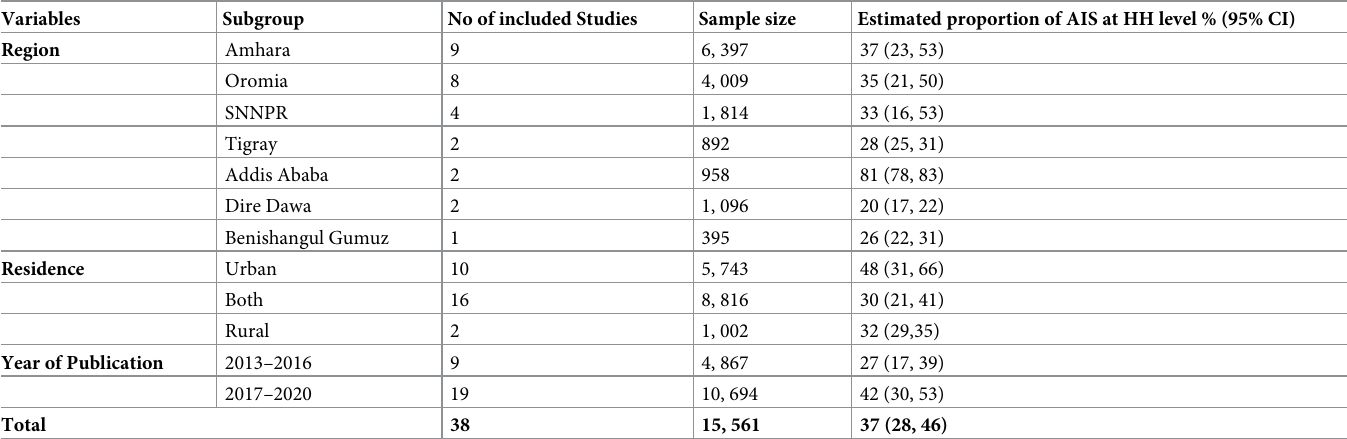
Table 2. Subgroup analysis of the pooled proportion of adequately iodized salt at the HH level in Ethiopia by region, residence, & year of publication, 2013–2020.